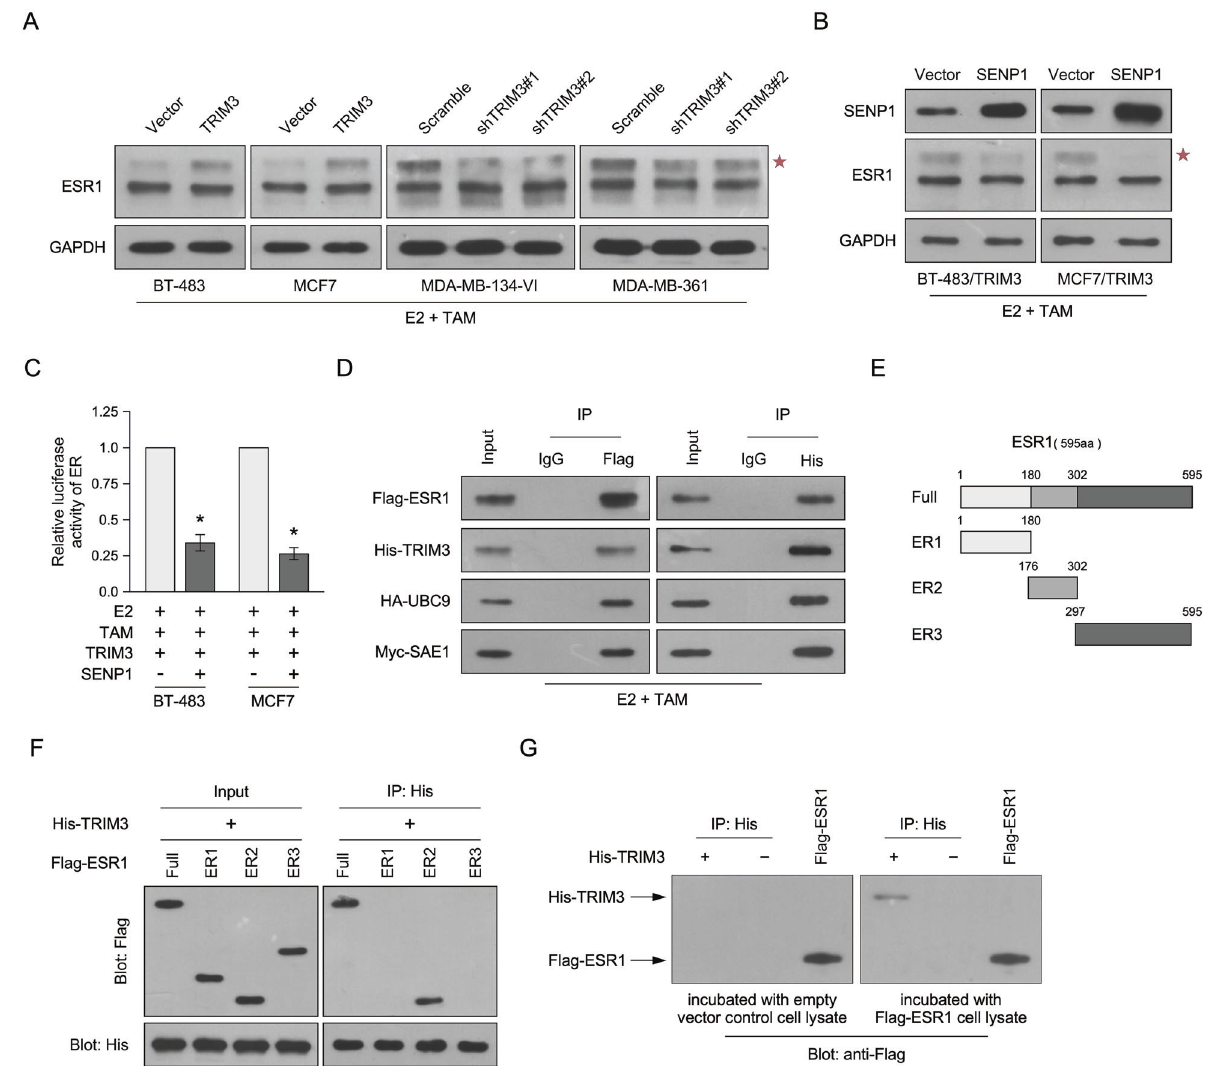
Fig. 4 TRIM3-induced SUMOylation of ESR1 via binding with UBC9. Western blotting of ESR1 ( A , B ) and SENP1 ( B ) levels in the indicated breast cancer cell lines. GAPDH was used as the loading control. A star represents SUMOylation of ESR1. C Estrogen response element (ERE) luciferase reporter activity was analyzed in the indicated cells treated with E2 (10 nM) and/or TAM (1 μ M). Data are presented as the mean ± SD. * P < 0.05. D Immunoprecipitation assay revealing that TRIM3 interacts with ESR1, UBC9, and SAE1 in the indicated cells. E Schematic illustration of wild-type ESR1 and truncated ESR1. F Immunoprecipitation assay revealing that TRIM3 interacts with the ER2 domain of ESR1. G Far-western blotting revealing that TRIM3 directly interacts with Flag-ESR1 in the cell